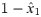
Hierarchical Gaussian Filter (HGF).(A) The perceptual model tracks an individual’s learning of the task’s structure across three levels. State x1 represents trialwise stimulus transitions from one stimulus to the next, x2 the probability of the transitions (i.e., transition contingencies), and x3 the phasic volatility, where t is the current trial number. Participants hold and update beliefs about the true quantities at each level, with a mean μ and a variance σ. ϑ and ω are participant-specific parameters that couple the levels and determine the respective speed of belief updating about phasic volatility and transition contingencies. The response model describes the mapping from a participant’s trialwise beliefs onto their observed log(RT) responses. (B) Example of the trialwise dynamics at level 3 from Placebo Participant 2. μ3 reflects the participant’s belief about the true phasic volatility (x3). Vertical dashed lines indicate true context switches. μ3 tends to increase following a context change and then decreases over the course of a context as the participant learns the new contextual rule and thus perceives the environment to be increasingly stable. √ϑ is a variance determining the step-size of μ3 and therefore how quickly the participant updates their phasic volatility estimates. (C) As in B, but for precision-weighted contingency prediction error [PE] (ε3) at level 2. This estimate results from weighting the contingency PE (δ2) by a precision ratio that captures uncertainty about input from the level below relative to the level above. The higher the precision at level 2, the more meaningful a deviation from the predicted stimulus transition contingency. This in turn increases the impact on phasic volatility belief updating at level 3. For simplicity, we only depict the ε3 trajectory for true transition changes. (D) As in B and C, but for sensory PE (δ1) at level 1. This estimate arises from irreducible uncertainty about stimulus transitions. Trialwise values are equivalent to 1−x^1, where x^1 is equal to the participant’s trialwise prediction of the occurring transition. Again, for simplicity we only show δ1 values for true transitions here. (E) Mean β values for the Placebo group indicate that increases in sensory PE (β1), precision-weighted contingency PE (β2), and phasic volatility estimates (β3) slowed participants’ trialwise log(RTs). There was also evidence of post-error slowing (β4). Results are mean ± SEM. * p < 0.05, ** p < 0.01, *** p < 0.001. http://dx.doi.org/10.6084/m9.figshare.3796356.v1.